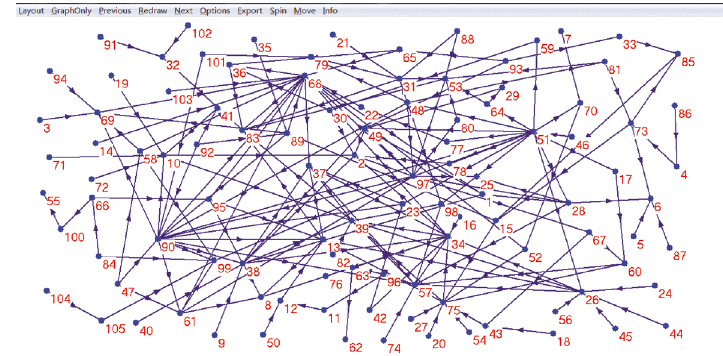
Figure 5: The coal mine risk network model in Pajek